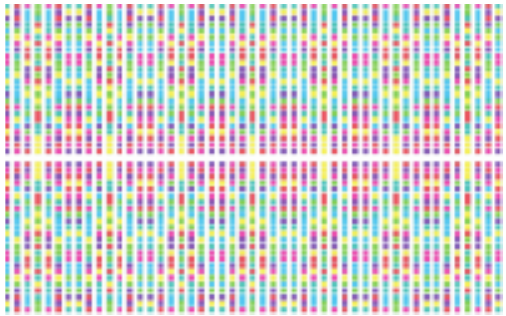
Figure 2.1. A tessellation of H 49 from GL(2, F 7 ). Any 7 points of di ff erent colors form a fundamental domain for GL(2, F 7 ) \ H 49